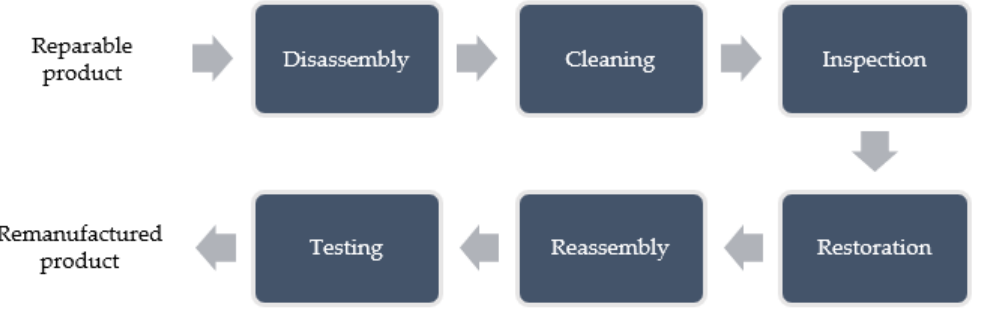
Figure 1. Process flow of remanufacturing. Figure 1 . Process flow of remanufacturing.